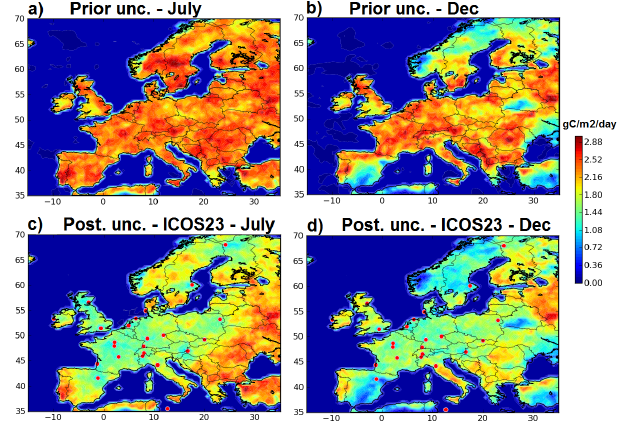
Figure 3. Standard deviations (gCm − 2 day − 1 ) of the prior (a, b) and posterior (c, d) uncertainties in a 2-week-mean NEE at 0.5 ◦ res- olution for (a, c) July and (b, d) December. Posterior uncertainties are given for inversions using ICOS23 (red dots) and the reference inversion setup. Red/blue colors indicate relatively high/low uncer- tainties (with min = 0gCm − 2 day − 1 and max = 3gCm − 2 day − 1 in the color